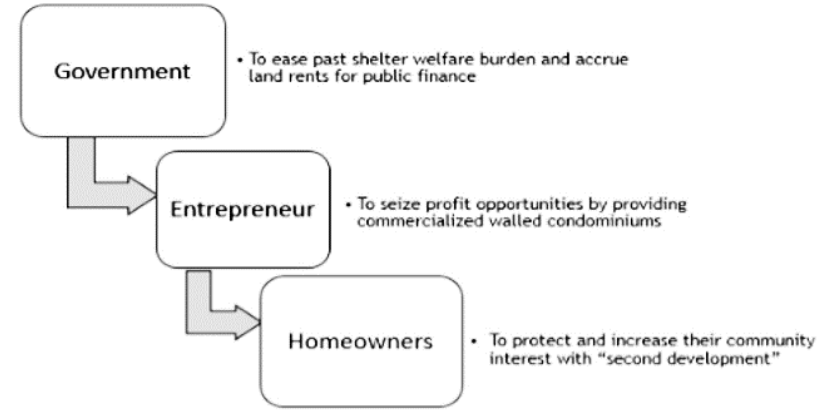
Fig. 5. Major Stakeholders’ Rational Consideration with Modern Communities (developed by the